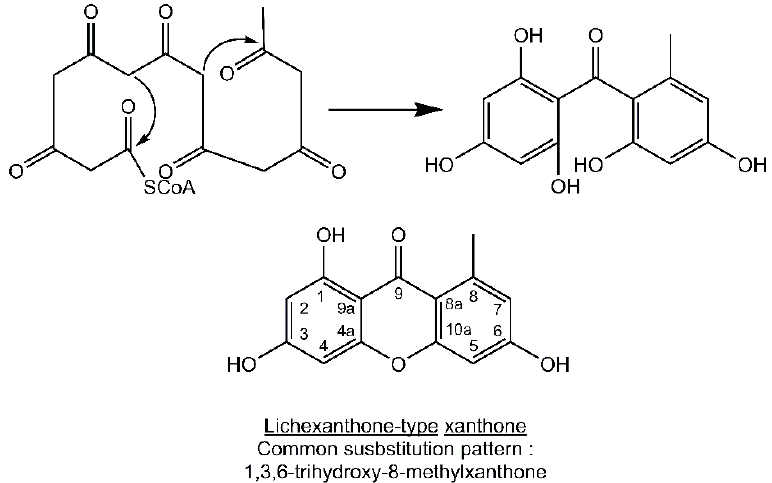
Figure 1. Proposed biosynthetic pathway for lichexanthone-type lichen xanthones. Adapted from [7].